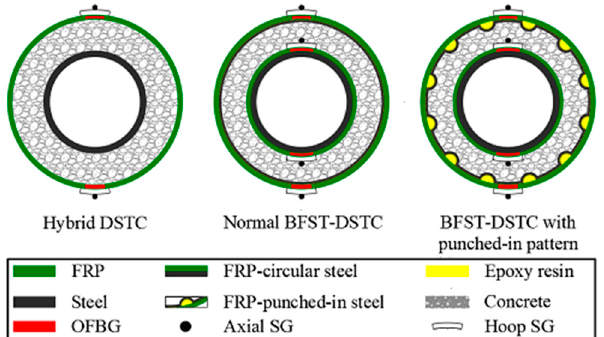
Figure 1. Cross-sectional design for hybrid FRP–concrete–steel double-skin tubular column (hybrid DSTC), normal BFST-DSTC, and BFST-DSTC with punched-in pattern.